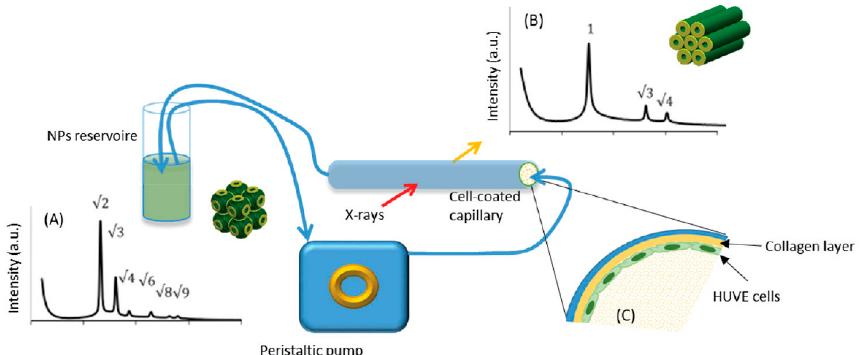
Figure 1. Scheme of the experimental setup. Phase transition from ( A ) cubosomes to ( B ) hexosomes, (the respective Bragg peaks indexing are indicated), when in contact with a glass tube coated with human umbilical vein endothelium cells (HUVE), was observed in situ with SAXS. ( C ) Detail of the observation cell coated with human umbilical vein endotheliumcells. (Adapted from [41]).